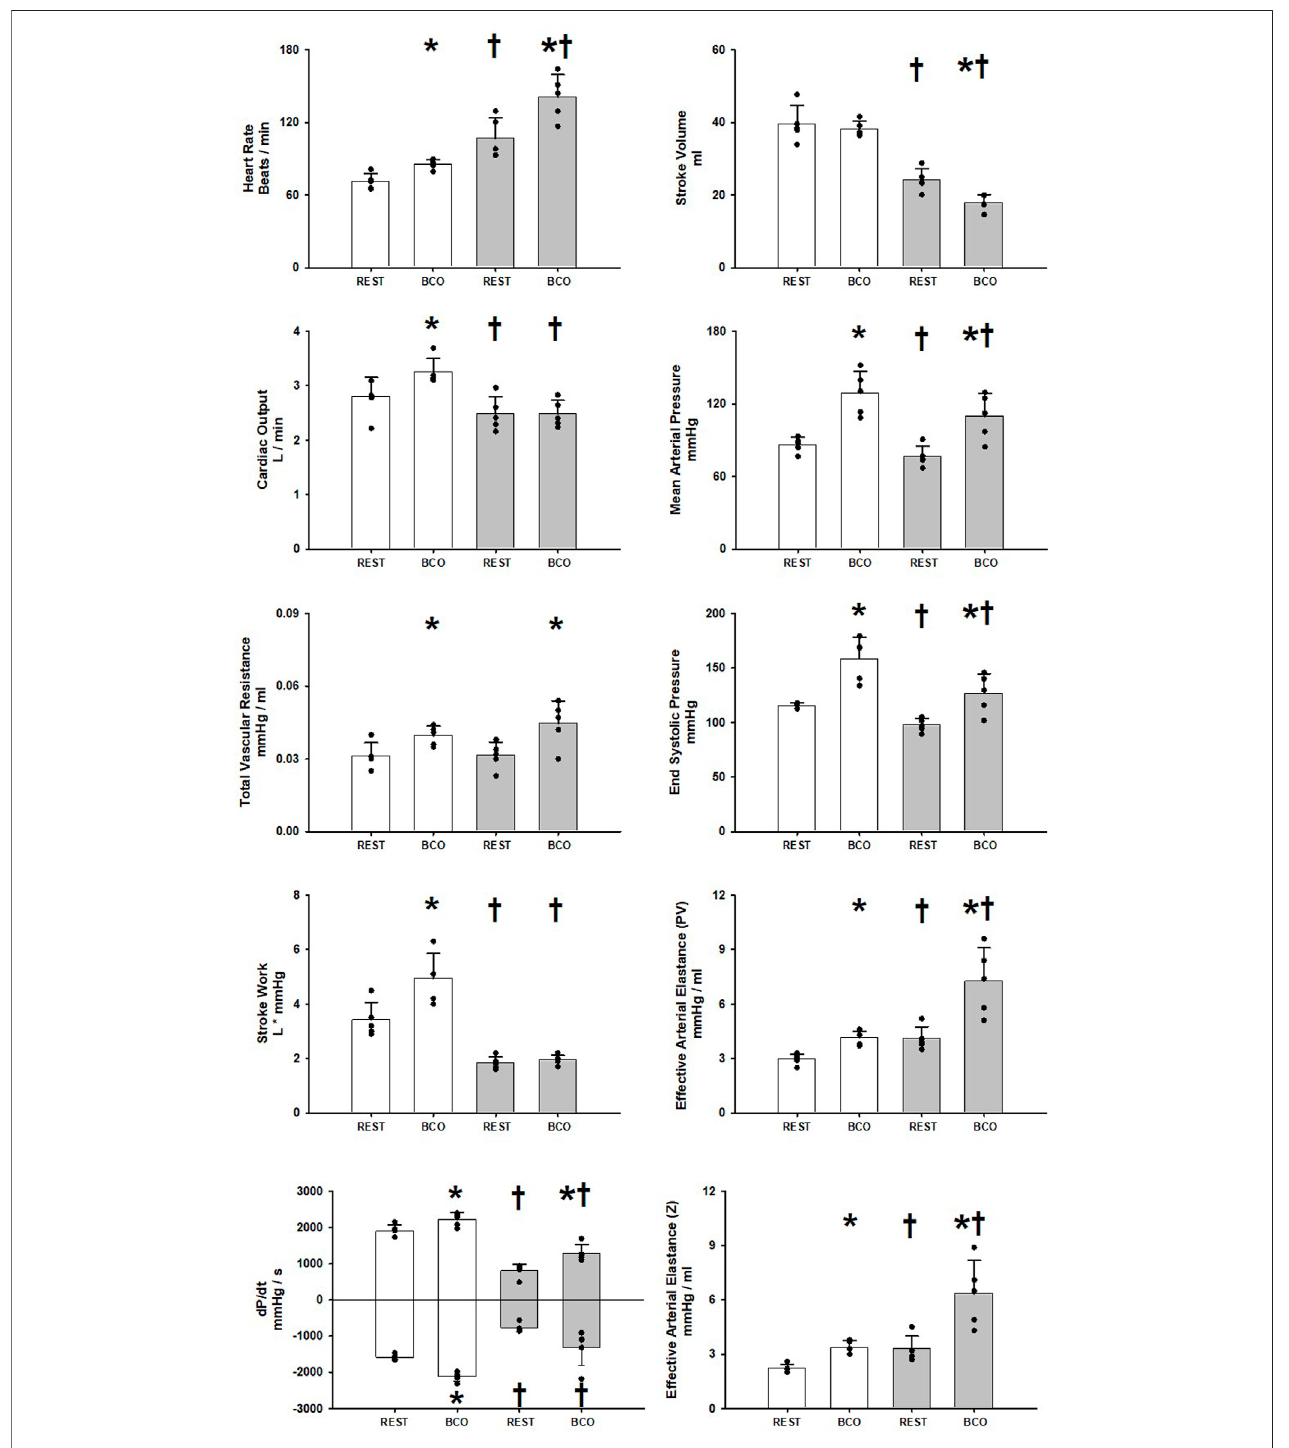
FIGURE1 | One-minute averaged hemodynamics at restand at rest with baroreceptor unloadingvia bilateral carotid occlusion (BCO) before(white bars) and after induction of heart failure (grey bars). Data are reported as mean with errors bars depicting the standard error of the mean. Actual observed data points are overlain on corresponding bar graphs. Statistical signi fi cance against the previous exercise workload depicted as * p < 0.05 and signi fi cant against previous state at the same workload depicted as † where p < 0.05. ( N = 5).